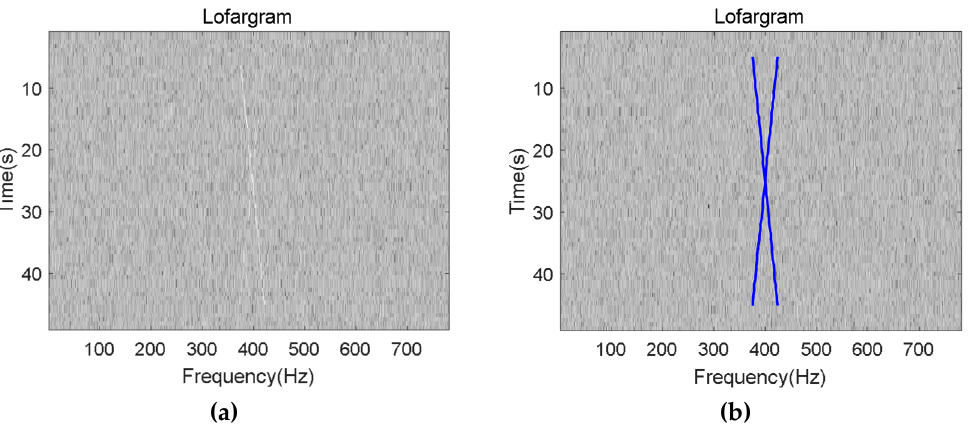
Figure 16. Line detection result of di ff erent method: ( a ) Traditional HMM-based method; ( b ) The method proposed in this paper.